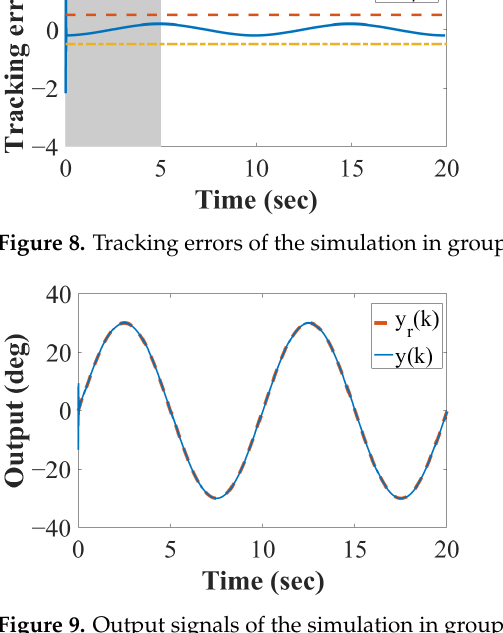
Figure 9. Output signals of the simulation in group 2 (proposed